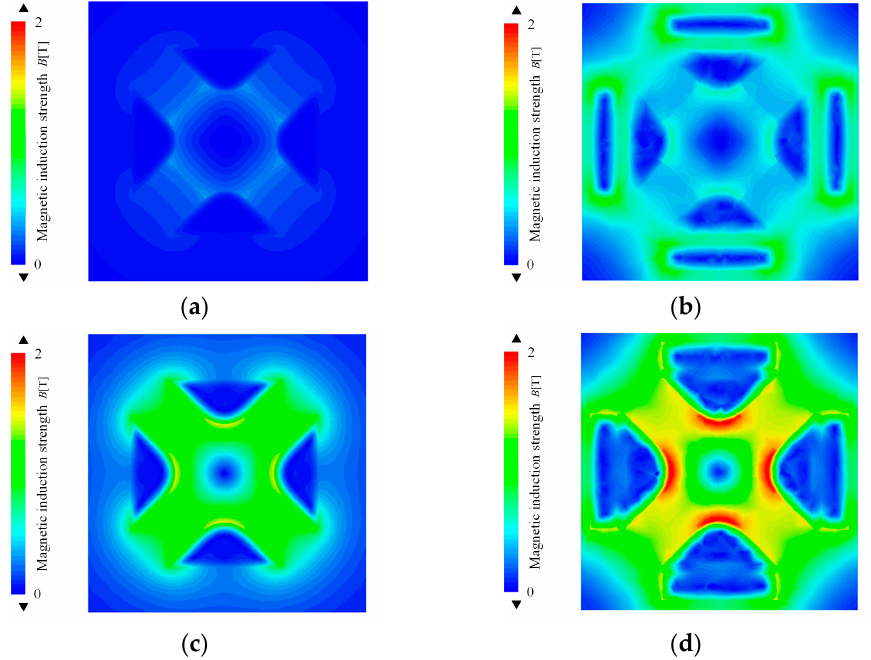
Figure 5. Magnetic field intensity distribution of the radial section: ( a ) nonenhanced front-end face; ( b ) enhanced front-end face; ( c ) nonenhanced rear-end face; ( d ) enhanced rear-end face.